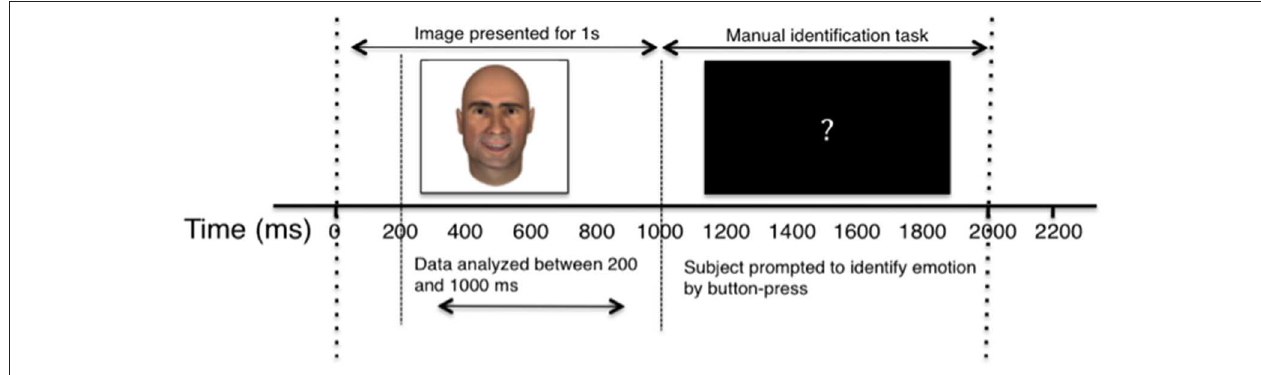
FIGURE 2 | Diagram of single experimental trial. The horizontal axis depicts the passage of time, in milliseconds. Dashed lines separate key stages of the experiment, and labeled arrow bars distinguish between the recording and behavioral